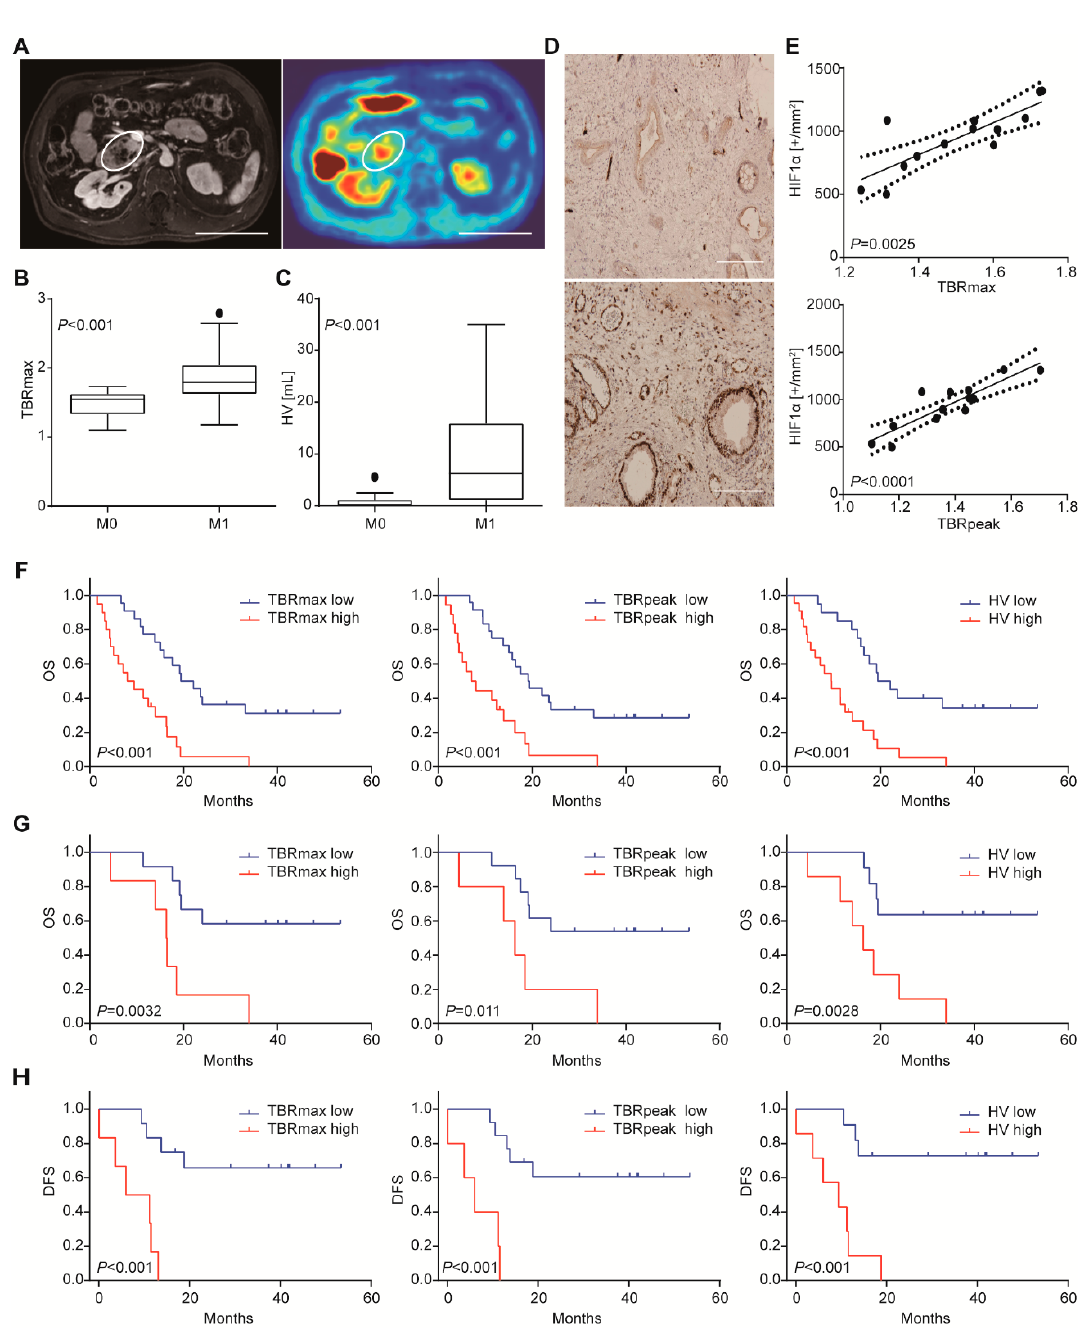
Figure 1. [ 18 F]HX4 uptake correlates with metastatic disease, cellular hypoxia, and poor outcome. ( A ) An example of contrast MRI ( left ) of tumor and corresponding PET/CT scan ( right ) demonstrating the high [ 18 F]HX4 intake area within the tumor. Scale bar: 10 cm. ( B ) Difference in [ 18 F]HX4 TBRmax and HV (panel C ) between patients with M0 and M1 stage disease. Significance was tested by two- tailed Mann–Whitney test. ( D ) Example of a patient with low ( top ) and high ( bottom ) [ 18 F]HX4 uptake and the corresponding HIF1 α stained slides of the tumor showing different degrees of cellular hypoxia. Scale bar: 200 µm. ( E ) Correlation between TBRmax ( top ), TBRpeak ( bottom ) and HIF1 α positively stained nuclei in the tumor. Kaplan–Meier survival curves discriminating patients based on TBRmax > 1.64, TBRpeak > 1.55 and HV > 1mL. ( F ) Overall survival for the entire population. ( G ) Overall survival for patients where the tumor was surgically resected. ( H ) As for panel G, showing disease-free survival.